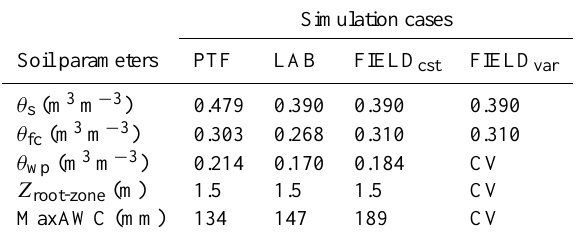
Table 4. Values of the soil parameters used in the simulations. PTF corresponds to the standard implementation of the model achieved with the ECOCLIMAP-II rooting depth ( Z root-zone ) and the pedo- transfer estimates of the wilting point ( θ wp ), the field capacity ( θ fc ) and the saturation ( θ s ). Distinct in situ estimates of these parameters are used in the other simulations. CV means time-variable values of Z root-zone and θ wp retrieved over each crop cycle (see Table 3). MaxAWC is the maximum root-zone water stock available for the